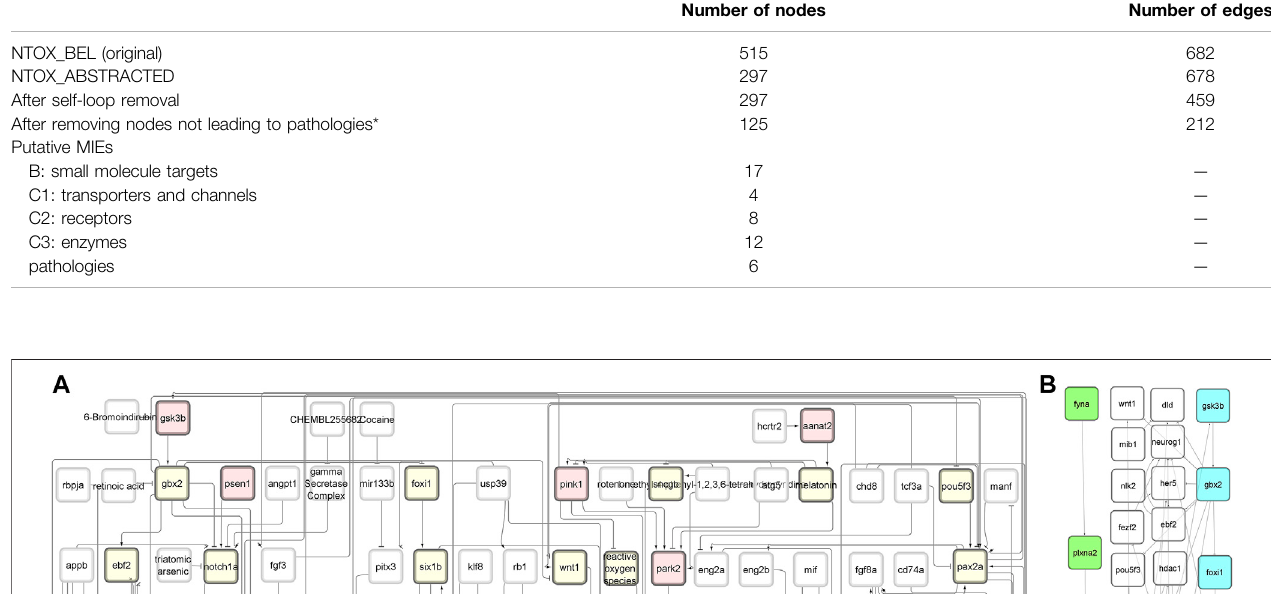
TABLE 1 | Zebra fi sh causal developmental network reduction through the different network manipulation steps described in Materials and Methods.